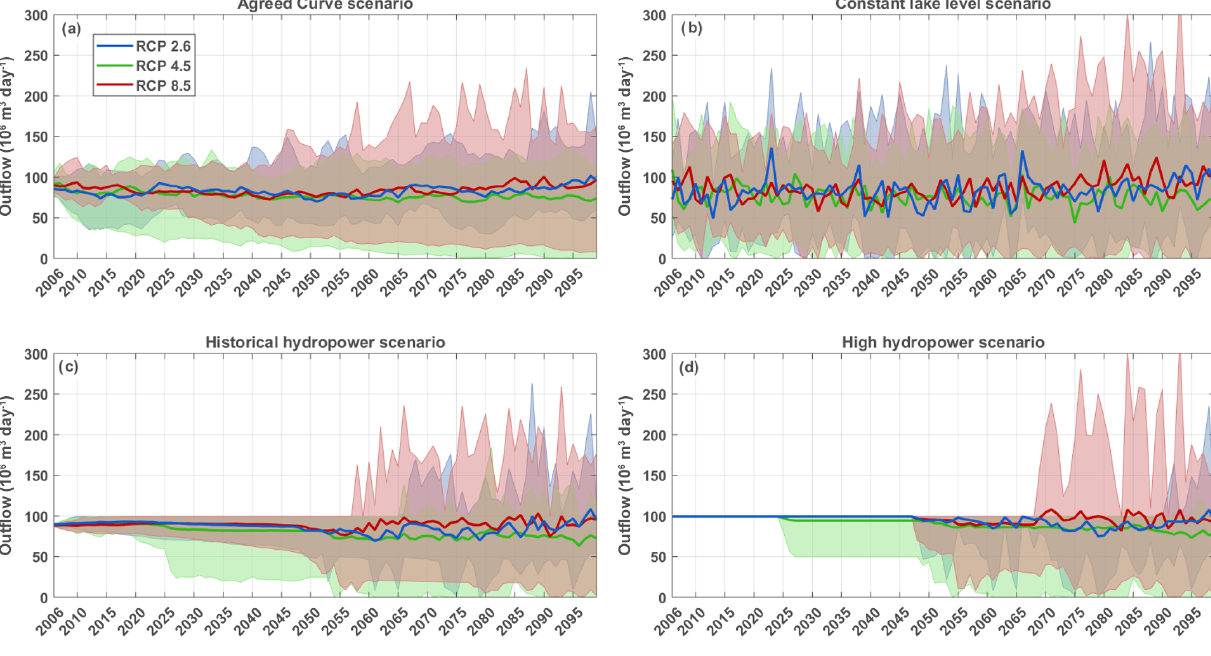
Figure E6. As in Fig. 9, but bias corrected using empirical